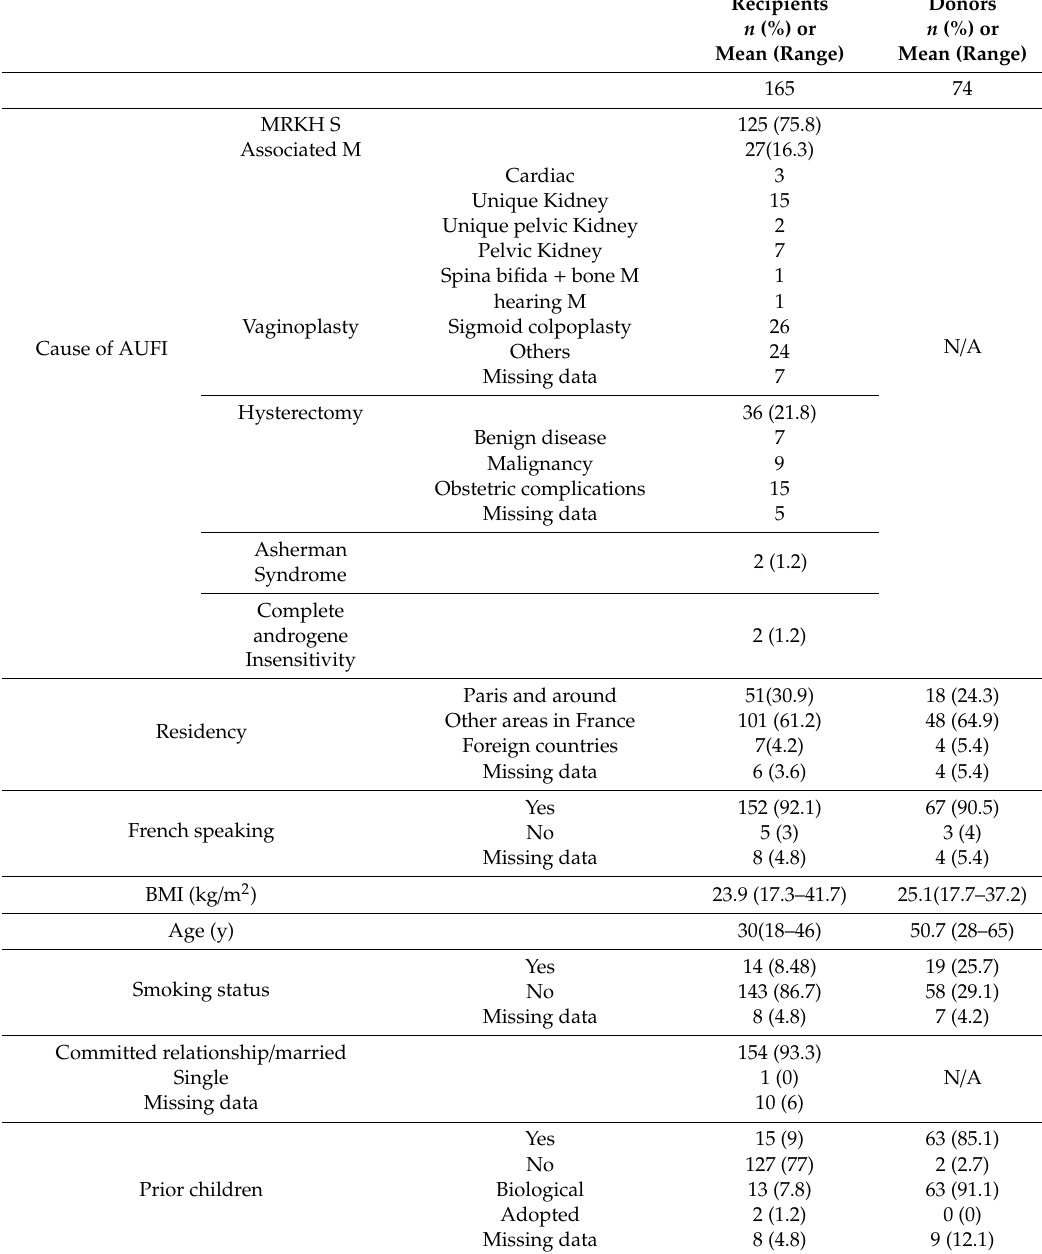
Table 2. Characteristics of potential recipients and